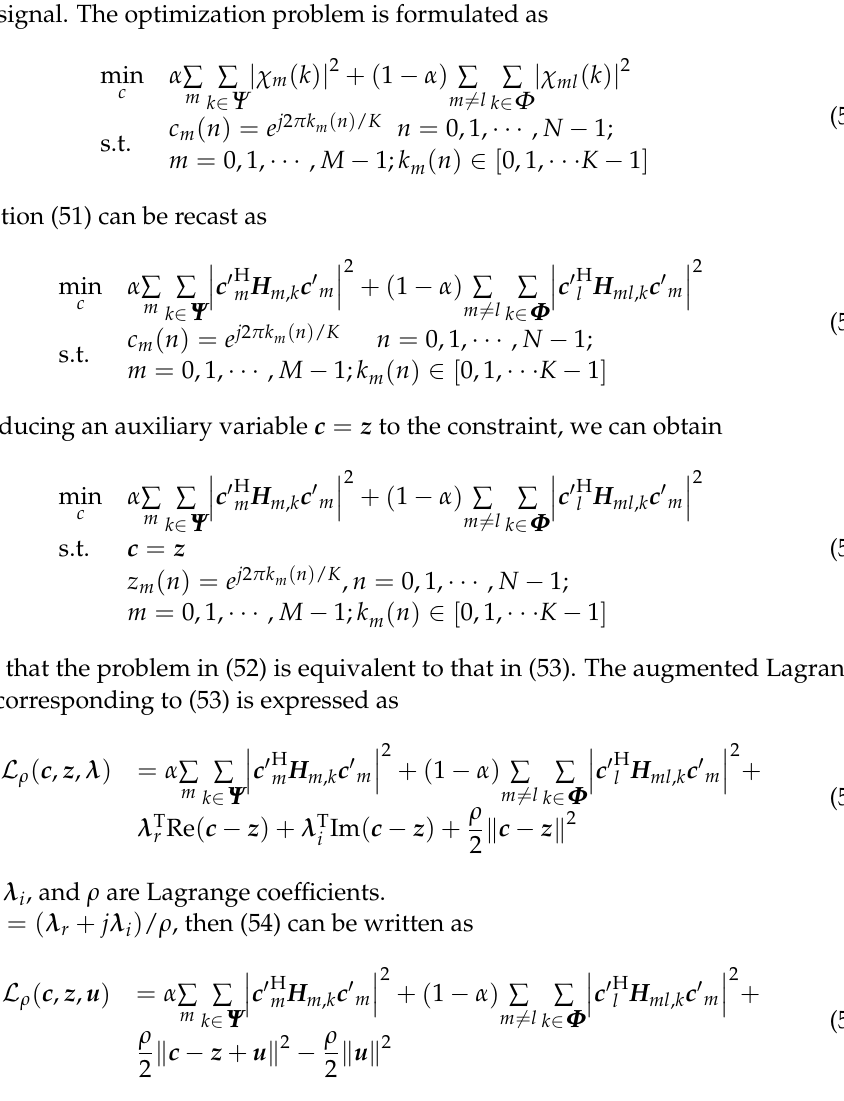
(cid:12) (cid:12) ( t + 1 ) − δ ( t ) (cid:12) (cid:12) ≤ ε —with ε being a small (cid:12) δ (cid:12)